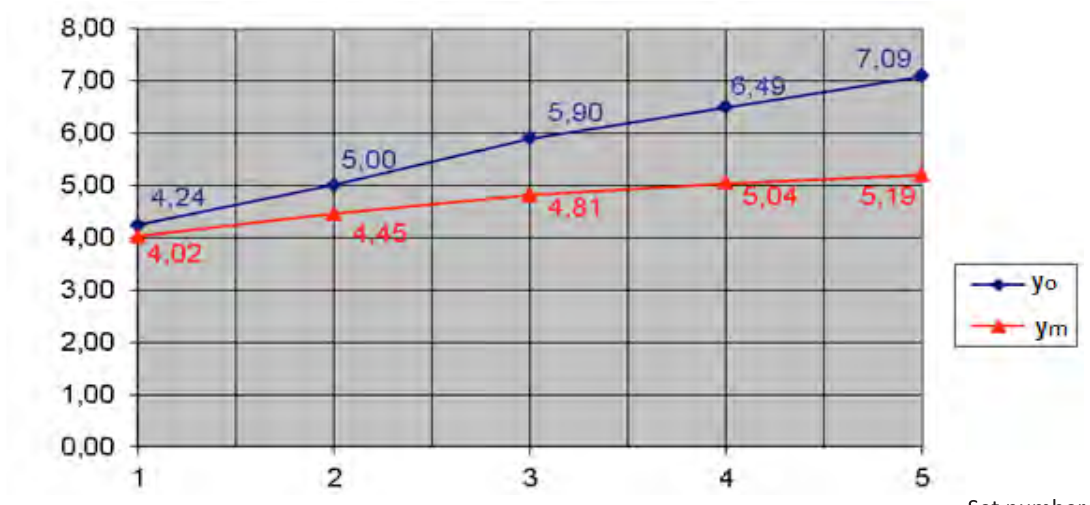
Fig. 1. Comparative analysis of experimental group data of October and May ping pong sets, where y and у – data for May; 1 – 5 numbers of sets; 0 – 8.00 – quantity of made mistakes. m